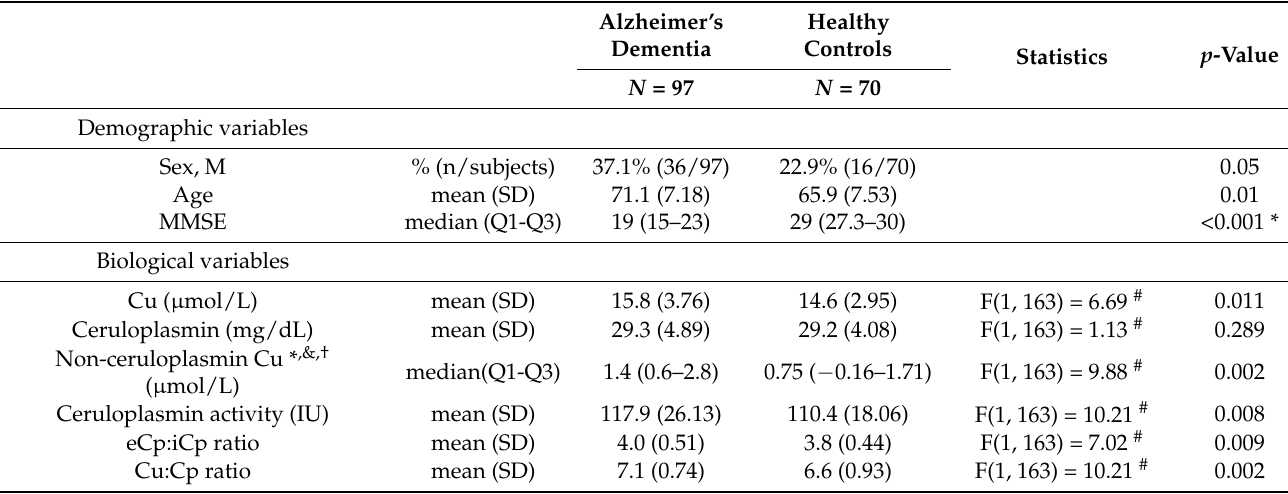
Table 2. Demographics and biological variables of participants to the replication study investigating variations of Cu markers in the serum of AD subjects and healthy